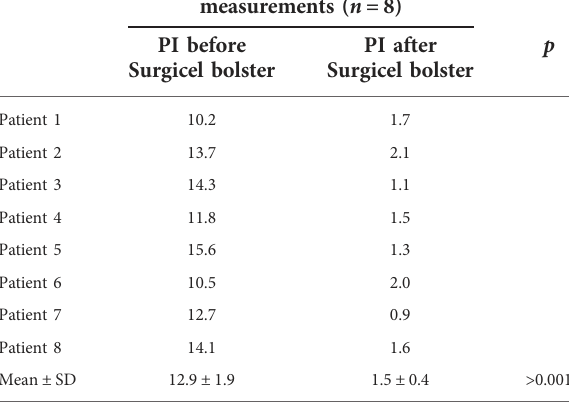
TABLE 2 Intraoperative pulsatility index measurements in last 8 patients in whom transit time fl owmetry was performed before and after correction of the arterial kinking with the hemostat-bolster